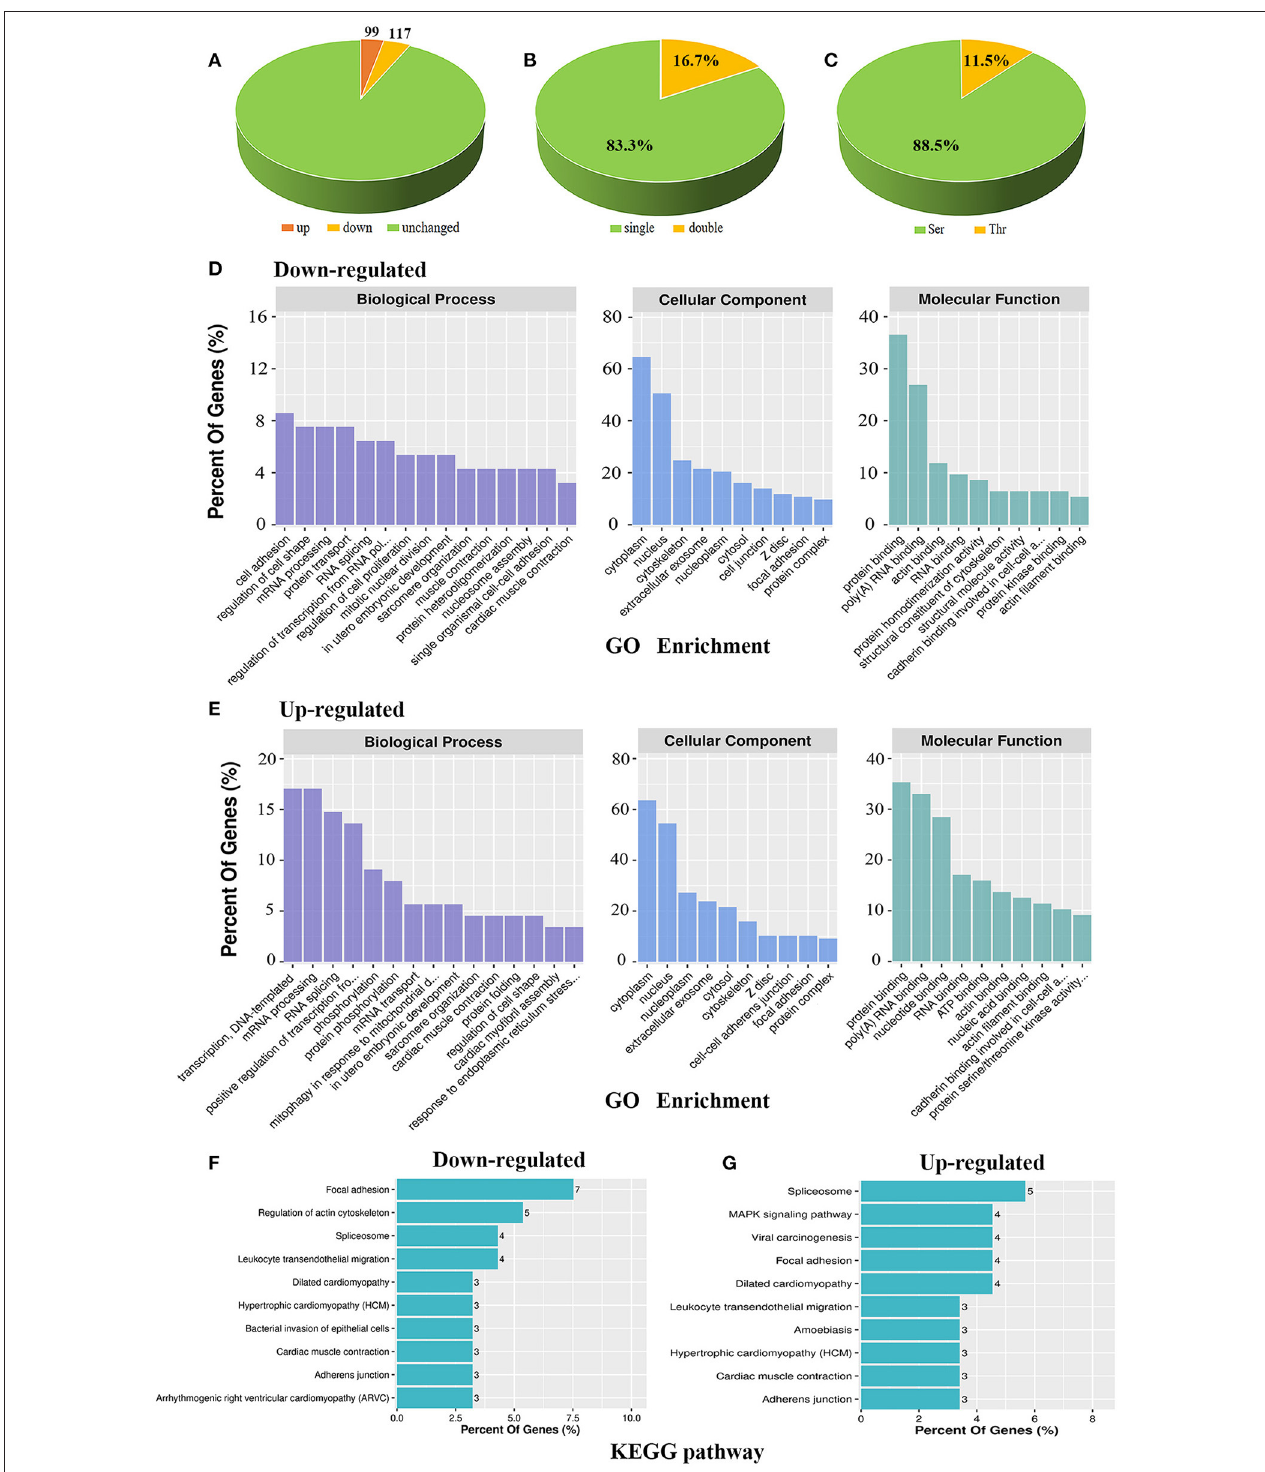
FIGURE 2 | Bioinformatic analysis of the phosphoproteomic results. (A) Distribution of differential phosphopeptides in Cypher-knockout (KO) mice compared to that in wild-type (WT) mice. (B) Distribution of single and double phosphosites based on differential phosphopeptides. (C) Distribution of serine (Ser) and threonine (Thr) phosphorylation based on differential phosphopeptides. (D,E) GO enrichment for biological process, cellular component, and molecular function in downregulated (D) and upregulated (E) phosphoproteins. (F,G) KEGG analysis of the top 10 signalling pathways that converge on downregulated (F) and upregulated (G)